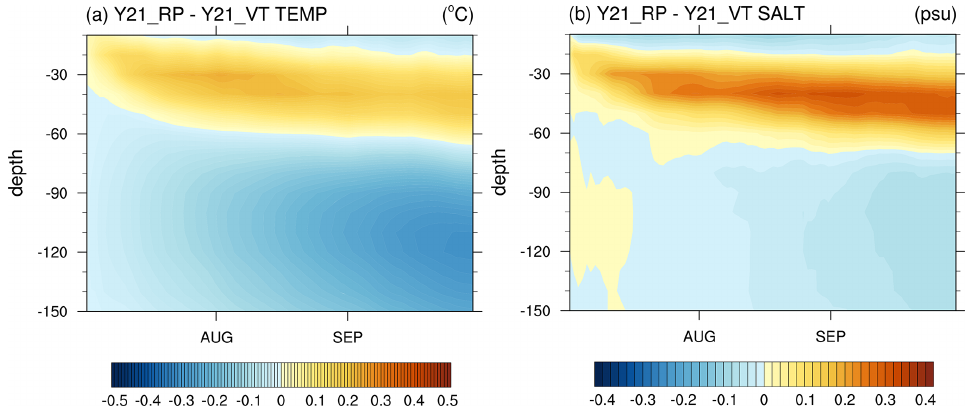
Figure 10. (a) The average temperature profile of upper 150m under ice-covered areas for the difference between Y21_RP and Y21_VT. Panel (b) is the same as (a) but for the salinity